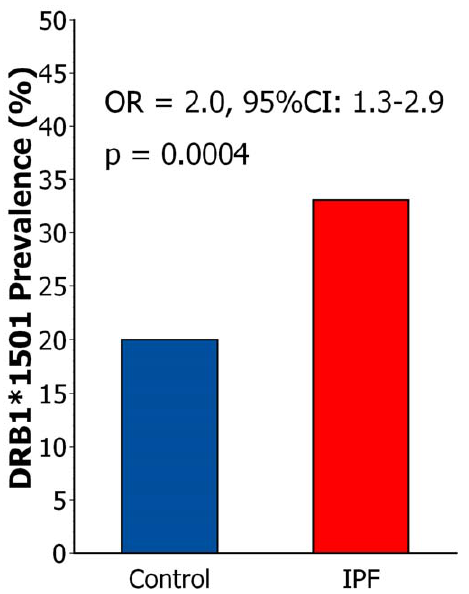
Figure 1. DRB1*1501 prevalence in IPF and controls. DRB1*1501 was significantly over-represented in the cumulative IPF population (n=275) compared to healthy controls (n=285).